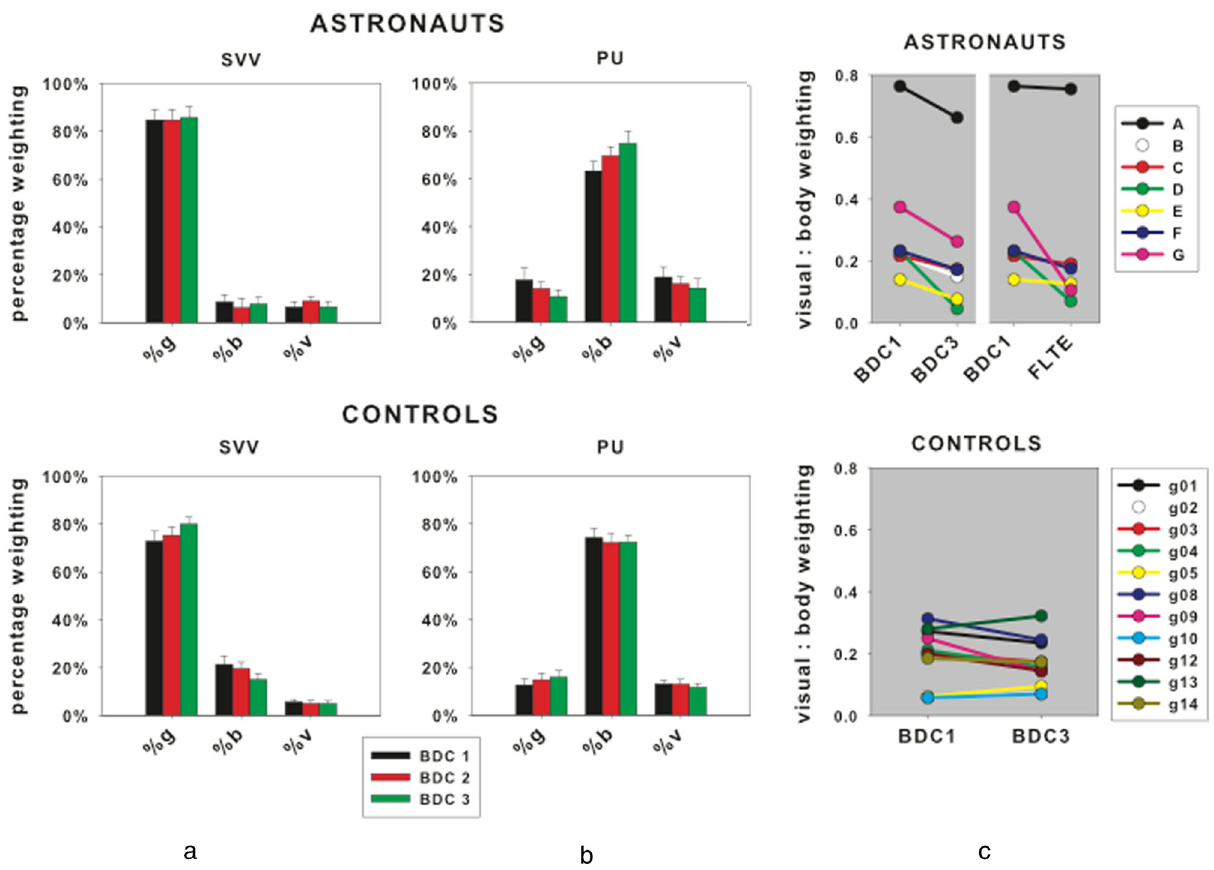
Fig. 4 The weightings of the three cues (gravity, body and vision) that determine the SVV ( a ) and PU ( b ), expressed as percentages, for astronauts ( top row ) and controls ( bottom row ) for each BDC session. SEs are also shown. c shows the ratio of vision to body weightings for each observer taken from the PU analysis for BDC1, FLTE and BDC3 for astronauts, and BDC1 and BDC3 for plotted against the comparable ratios of the actual measured variances in Fig. 6 for all astronauts in each data collection session. The ratios obtained from the k-variances were not signi fi cantly different from the ratios of the measured variances for either comparison. This indicates that the relationship between the reliability of each cue and its weighting is consistent with MLE principles.